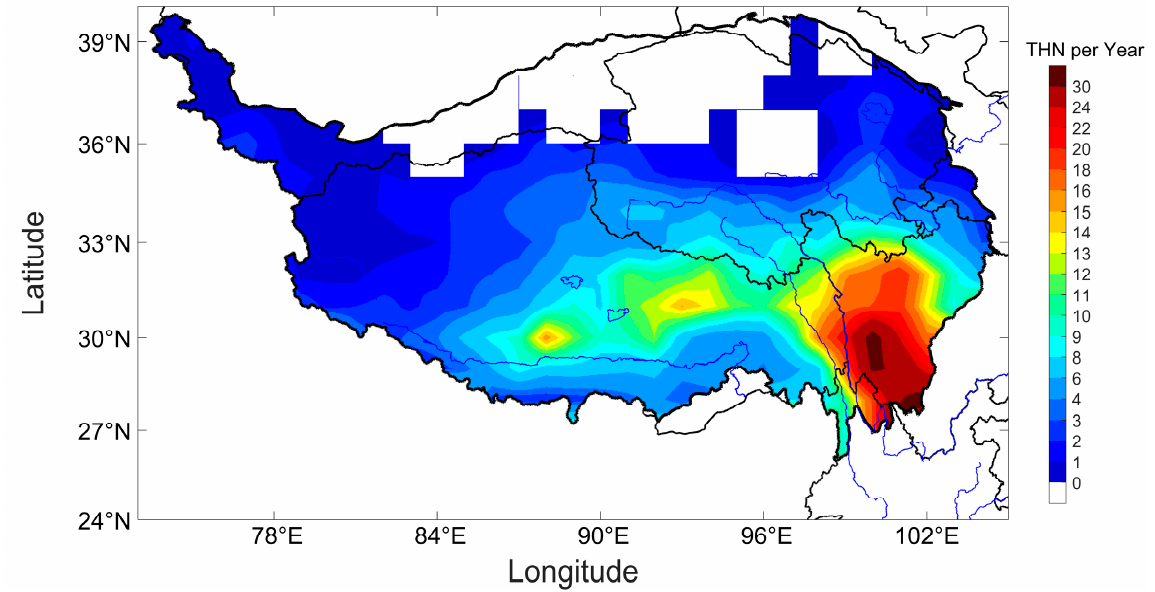
Figure 11. Spatial distribution of extreme-lightning thunderstorms over the QTP with the statistical grid being 1° × 1°.